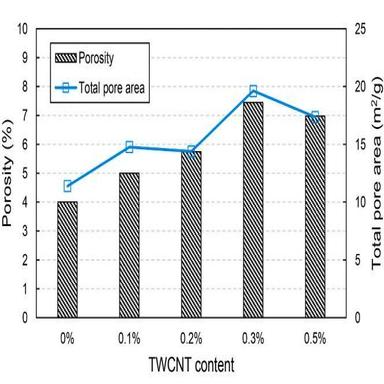
Porosity and total pore area of the samples at 28 d of curing.